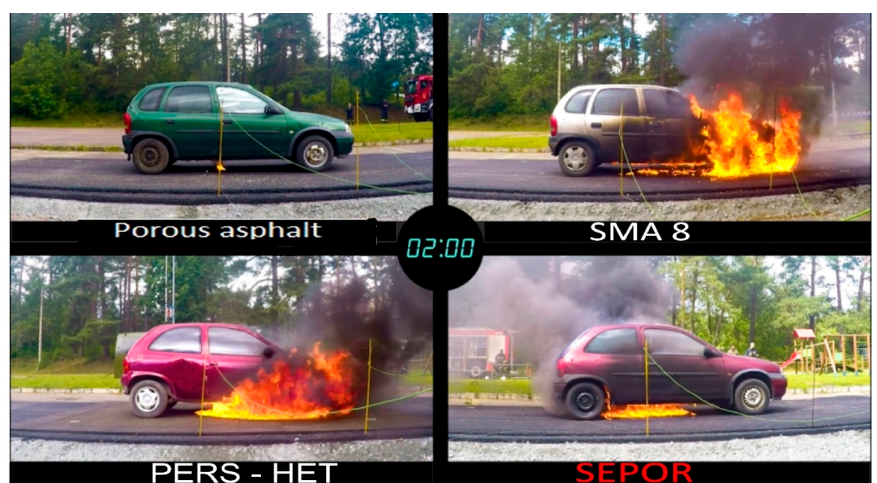
Figure 35. Fire development 120 s after ignition.